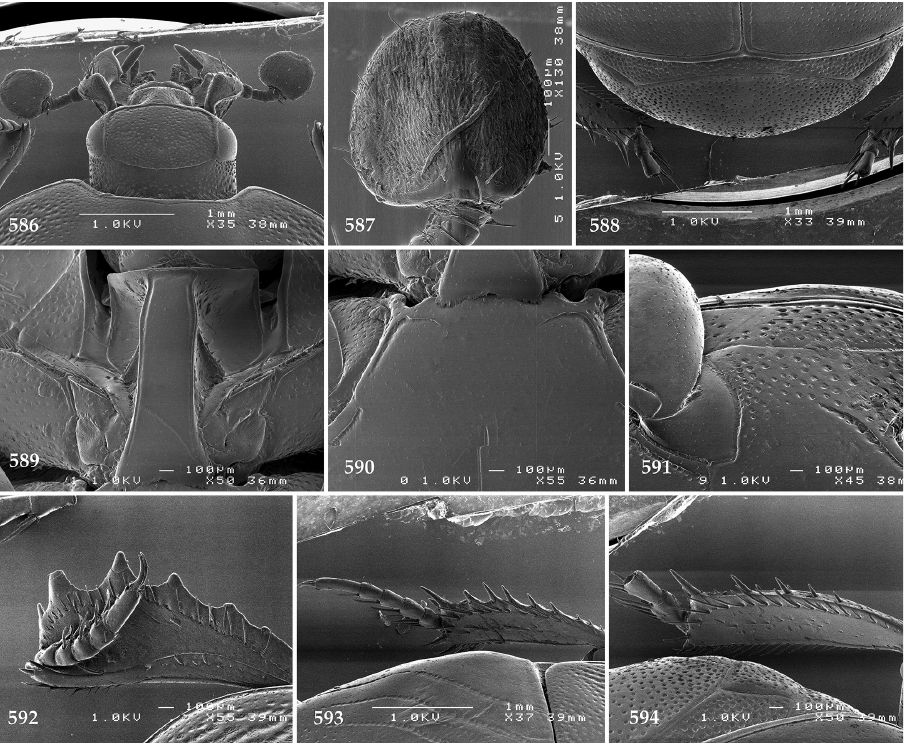
Figures 586–594. 586 Saprinus ( Saprinus ) viridanus Lewis, 1899 head, dorsal view 587 antennal club, ventral view 588 propygidium + pygidium 589 prosternum 590 mesoventrite 591 lateral disc of metaventrite + metepisternum 592 protibia, dorsal view 593 mesotibia, dorsal view 594 metatibia, dorsal